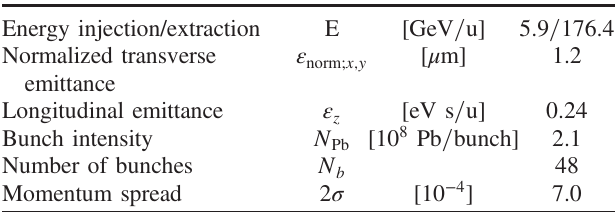
TABLE III. Relevant baseline parameters of HL-LHC lead ion beams in the SPS